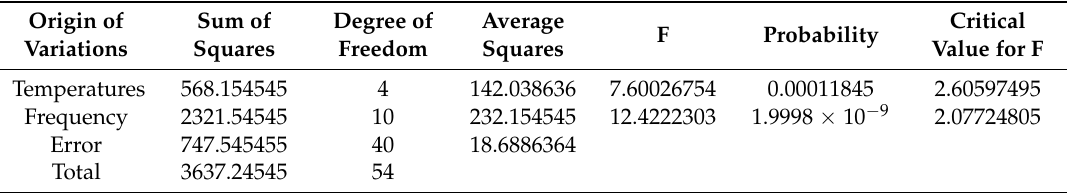
Table 5. ANOVA for